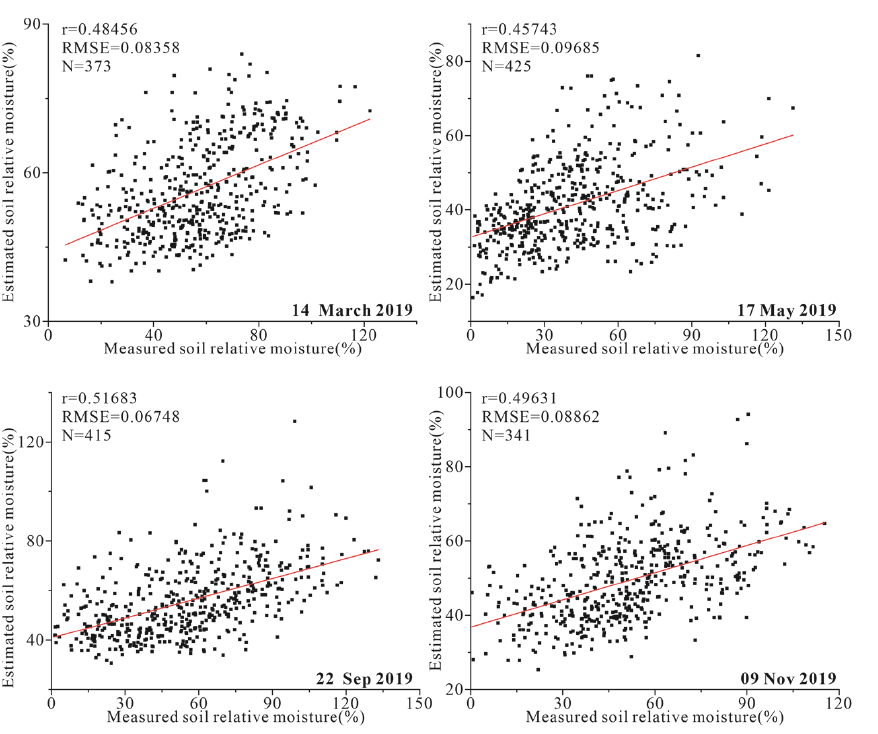
Figure 5. The scatter plot between measured and estimated soil relative moisture.